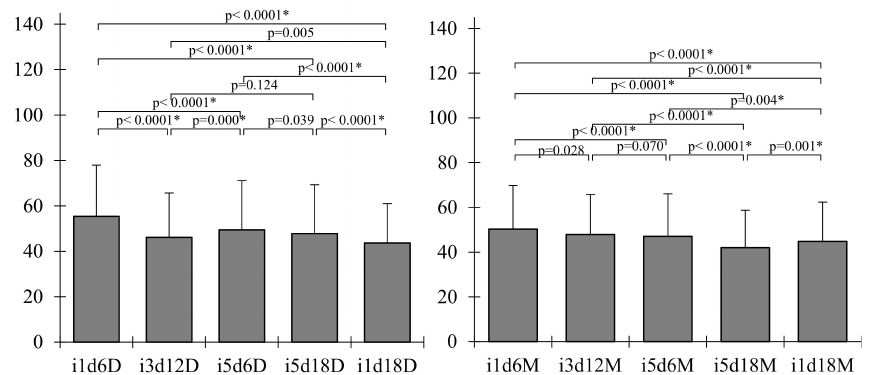
Figure 7. Kruskal–Wallis graphic test showing fiber diameter differences among BC dry and moist membranes. i—inoculum, d—harvest day, M—moist membrane, D—dry membrane; the